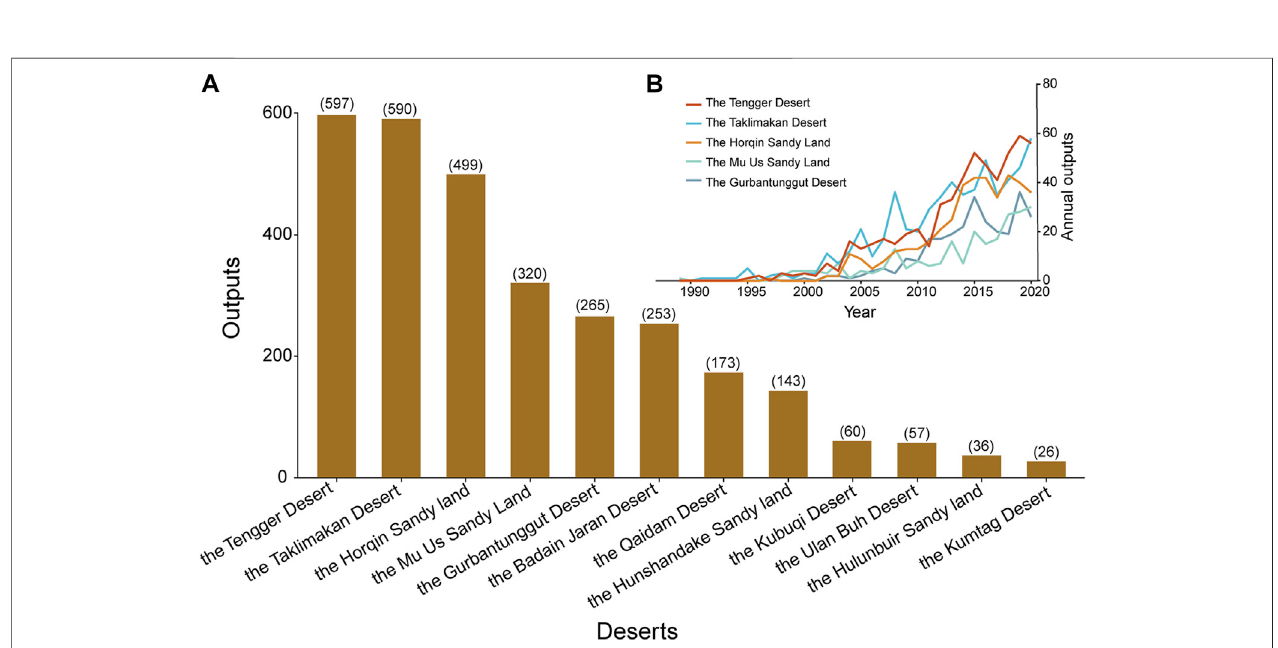
FIGURE 2 | Outputs published for the main deserts in China from 1986 to 2020 on the SCI-E database. (A) Total outputs for the 12 main deserts. The outputs numbers are listed in parentheses. (B) Annual outputs for the fi ve most productive deserts.